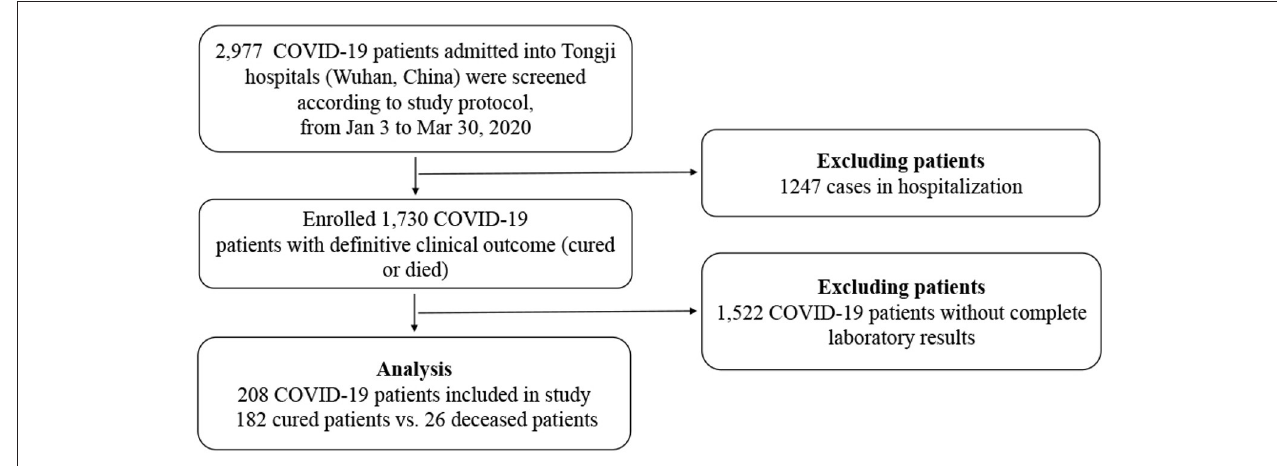
FIGURE 1 | Study flow